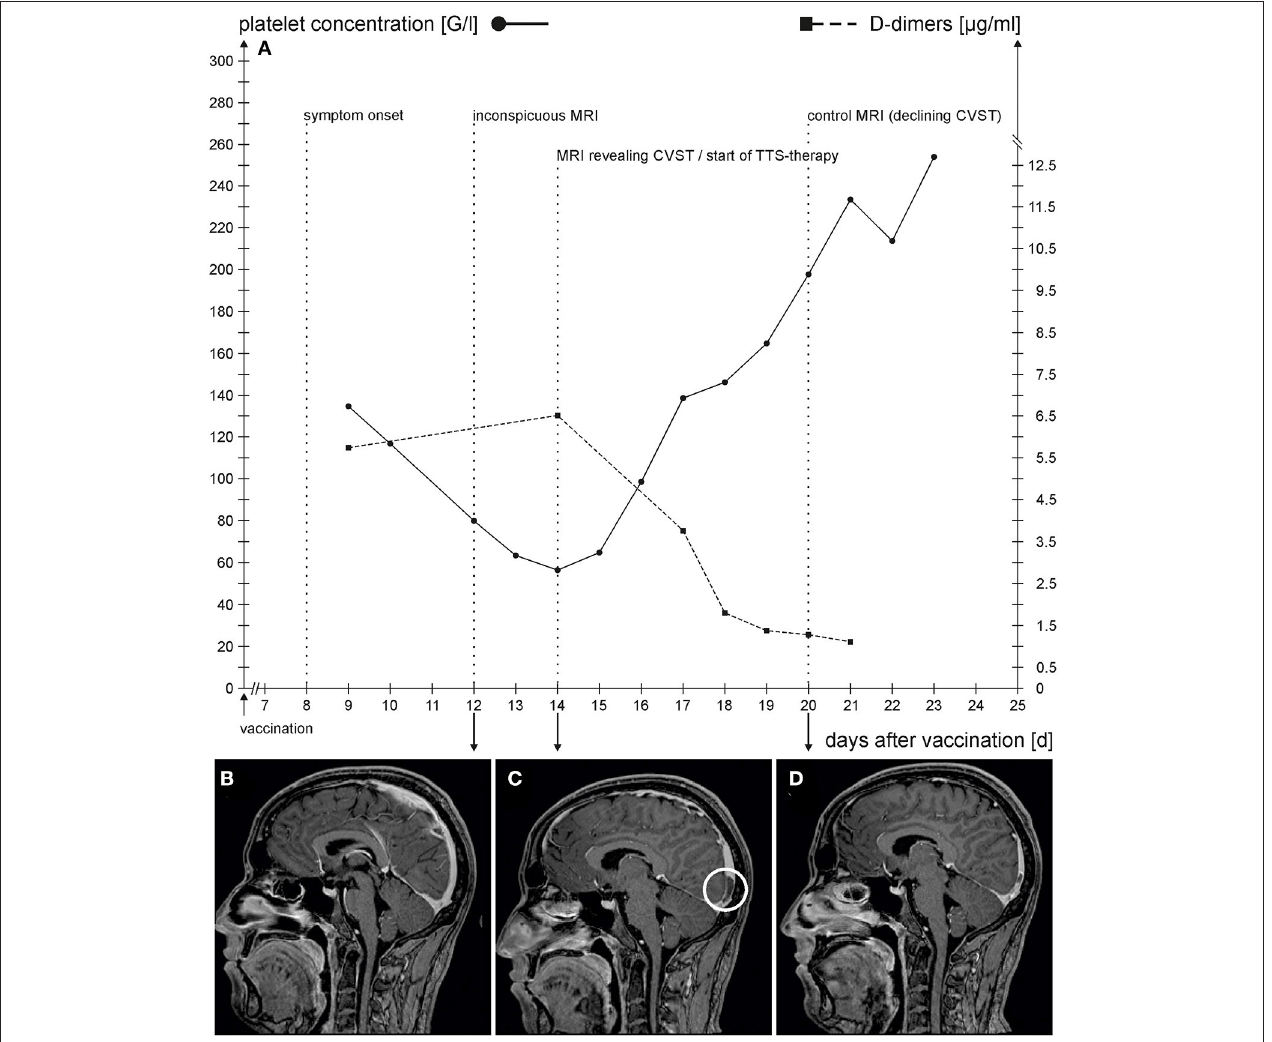
FIGURE 1 | (A) Time course of symptom onset, laboratory findings of platelet count (solid line)/D-Dimer (dashed line), and imaging studies. The x-axis represents the number of days after vaccination. (B–D) show sagittal contrast-enhanced T1-weighted MRI-sequences; (B) no evidence of thrombosis in the sagittal superior sinus at day 12 following vaccination; (C) thrombosis of the sagittal superior sinus (circle) at day 14 following vaccination; (D) regression of thrombosis at day 20 following